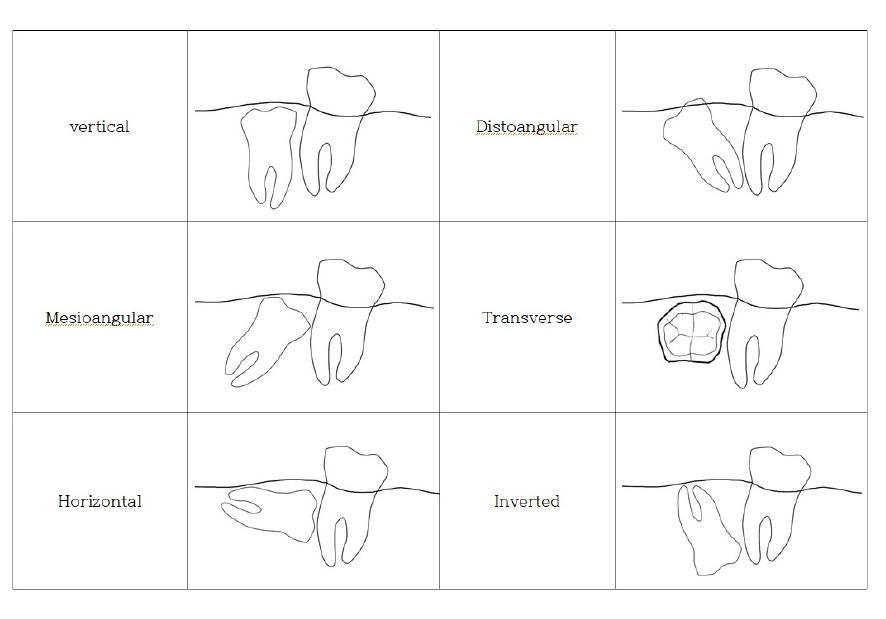
Figure 2. Winter’s